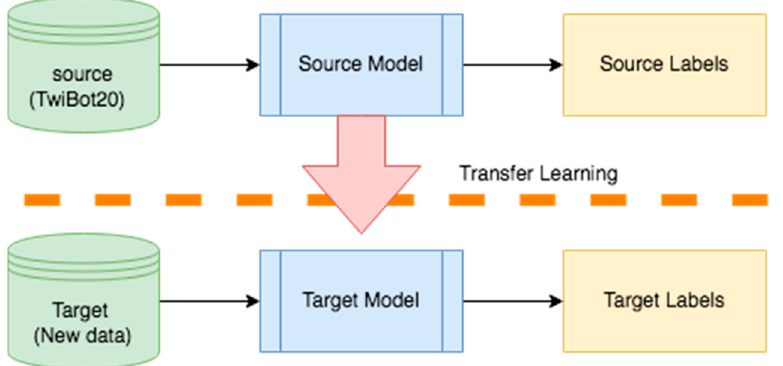
Figure 2. Illustration of transfer learning in our case scenario. Twibot20 was used as a source to train our model, Bot-MGAT, and to train target data that were new and unlabeled, to predict the labels.